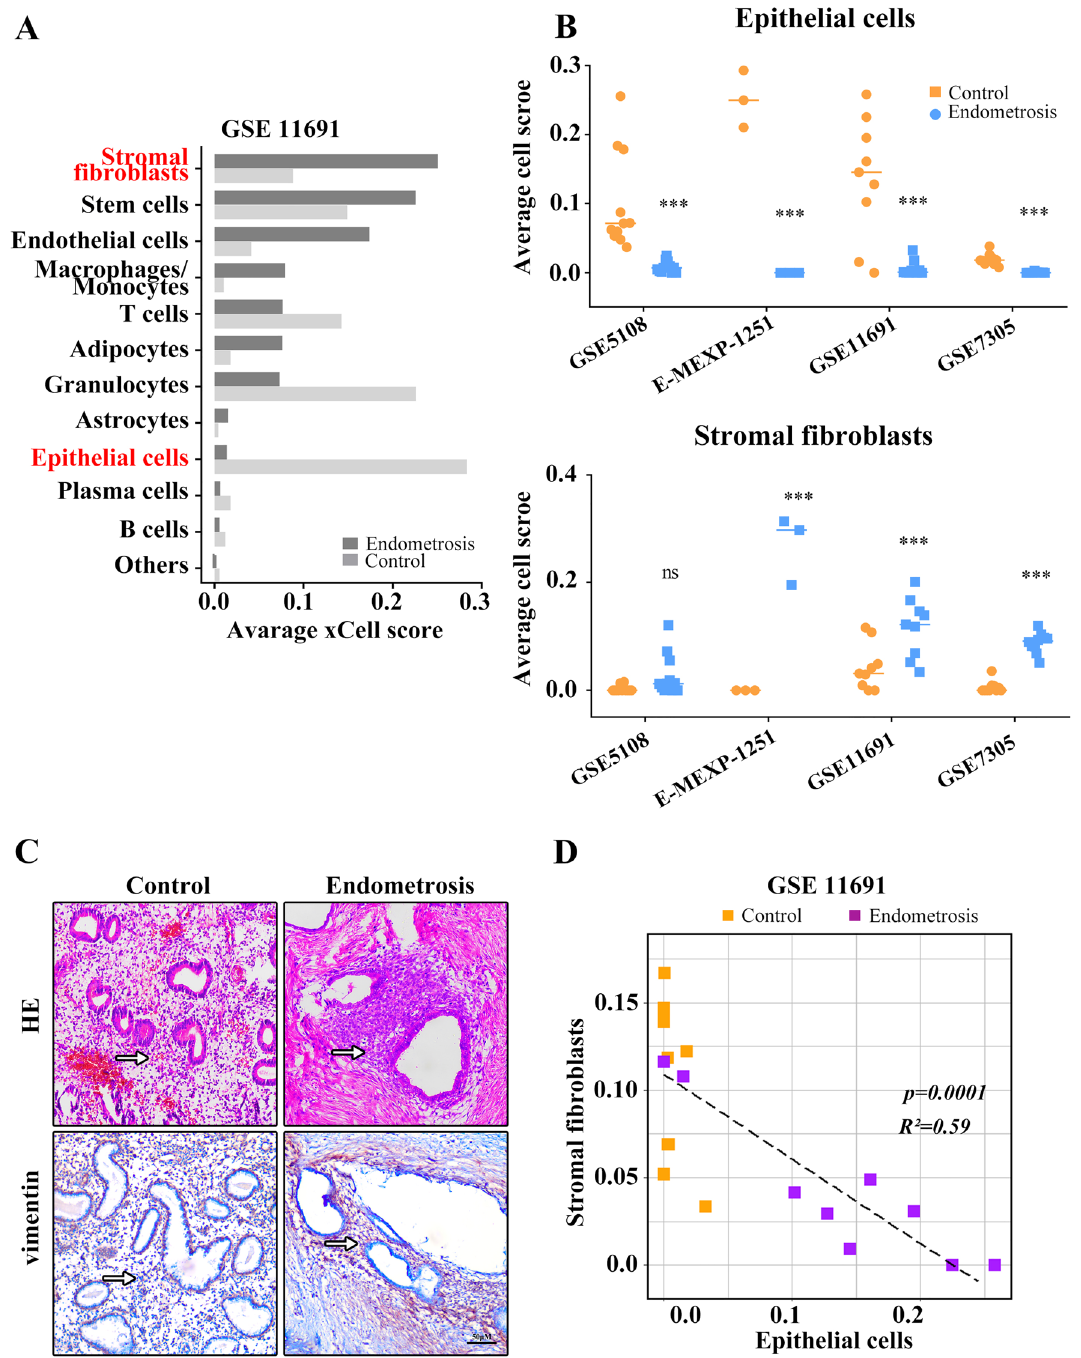
Figure 3. Endometrial stromal fibroblasts were enriched in endometriosis compared to other cell types. Computational biology analysis revealed the total content of different cells in the tissues of the control and endometriosis (GSE11691, n = 10) ( A ). Endometrial stromal fibroblast and epithelial cell abundance scores in tissues of the control and endometriosis, as calculated by xCell ( B ). HE staining and vimentin immunohistological staining showing stromal fibroblasts and epithelial cells ( C ). Abundance score correlation analysis for stromal fibroblasts with epithelial cells in tissues of the control and endometriosis ( D ). Scale bars = 50 µm in ( C ). *** p <